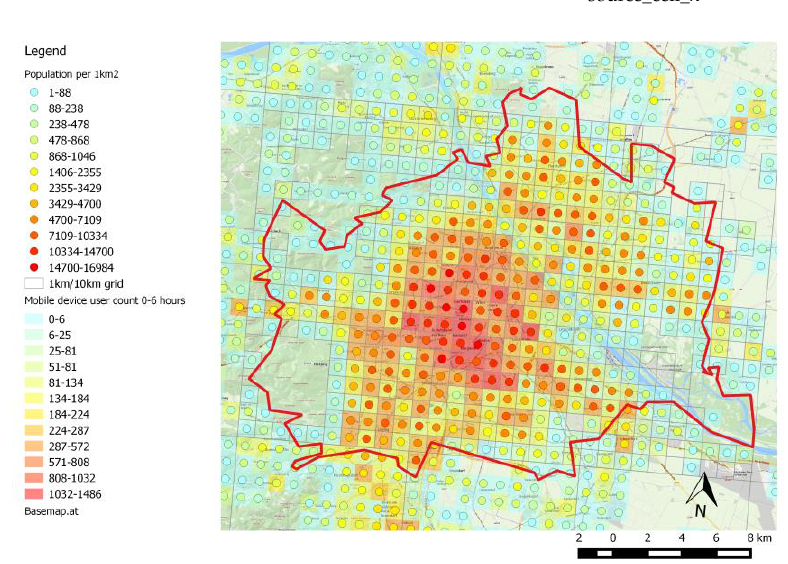
Figure 6. Visual comparison between 1 km 2 statistical population of Vienna (dot signature) vs. 1 km 2 mobile phone user densities between 0 and 6:00 (square signature).